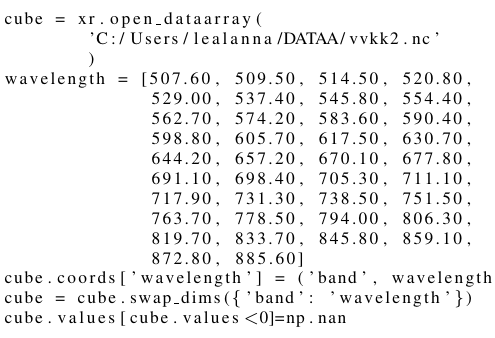
Figure 2. Here we read the cube, attach wavelength data to it and remove non-physical negative values.